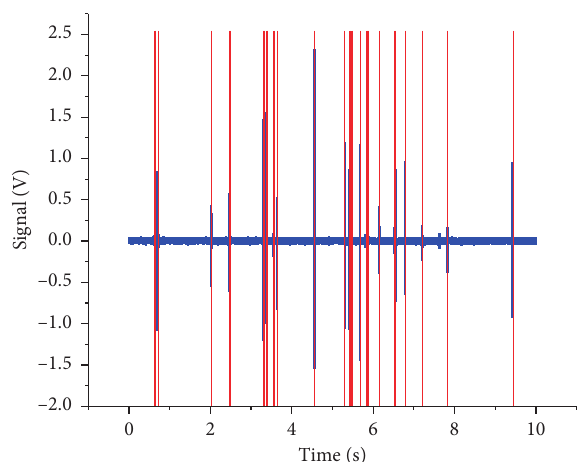
Figure 11: Signal with detected peaks marked, threshold � 2.5. Barley, 50 seeds delivered in batch. Blue lines show signal values, and the red lines denote the detection performed by the algorithm. It is possible to conclude that all significant events are counted, apart from one probable hit between 7.5-8s. The figure proves the algorithm’s capability to distinguish recoils from original hits for more accurate counting.